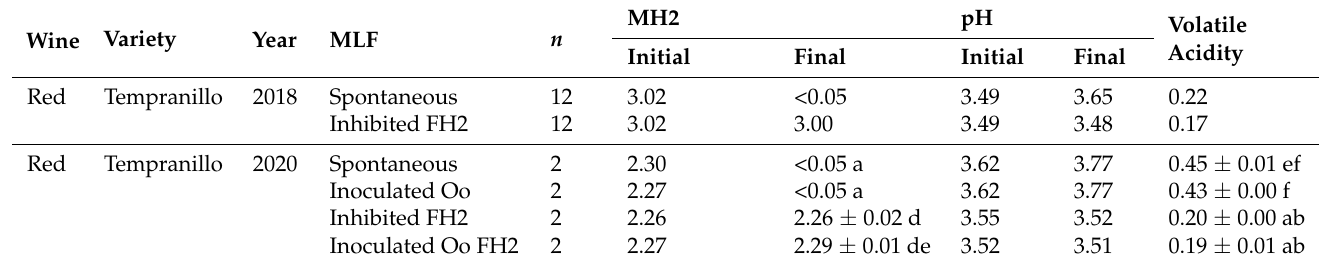
Table 2. Effect of fumaric acid (600 mg/L) in the inhibition of malolactic fermentation (MLF) in red, rose, and white wines: impact in malic acid (g/L), pH and volatile acidity (g/L). MLF started by inoculation with Oenococcus oeni strain alpha or spontaneously with wild lactic acid bacteria. When n = 3, values are means ± standard deviations. Significant differences are indicated by different letter ( p < 0.05). One way ANOVA and mean tests have been performed per